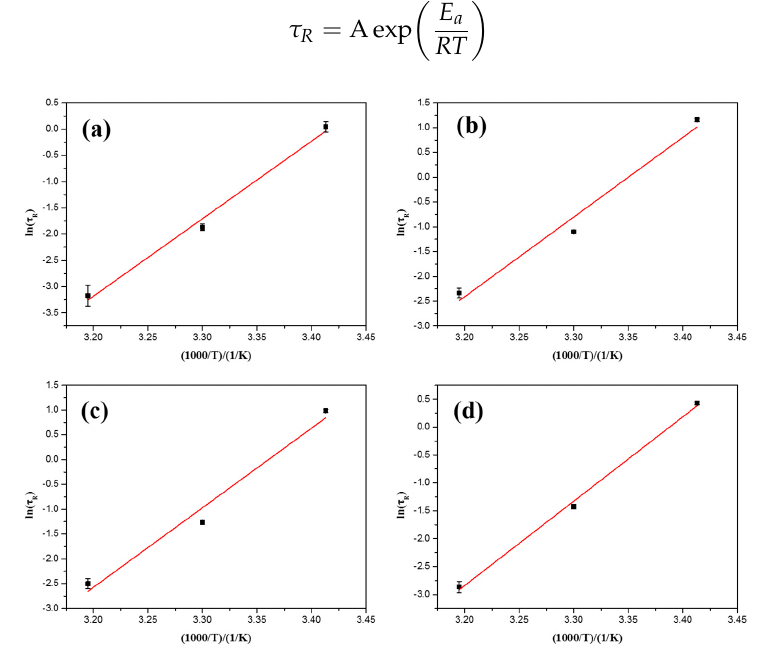
Table 2. The activation energy E a of NEWMS with different silica nanoparticle concentrations.